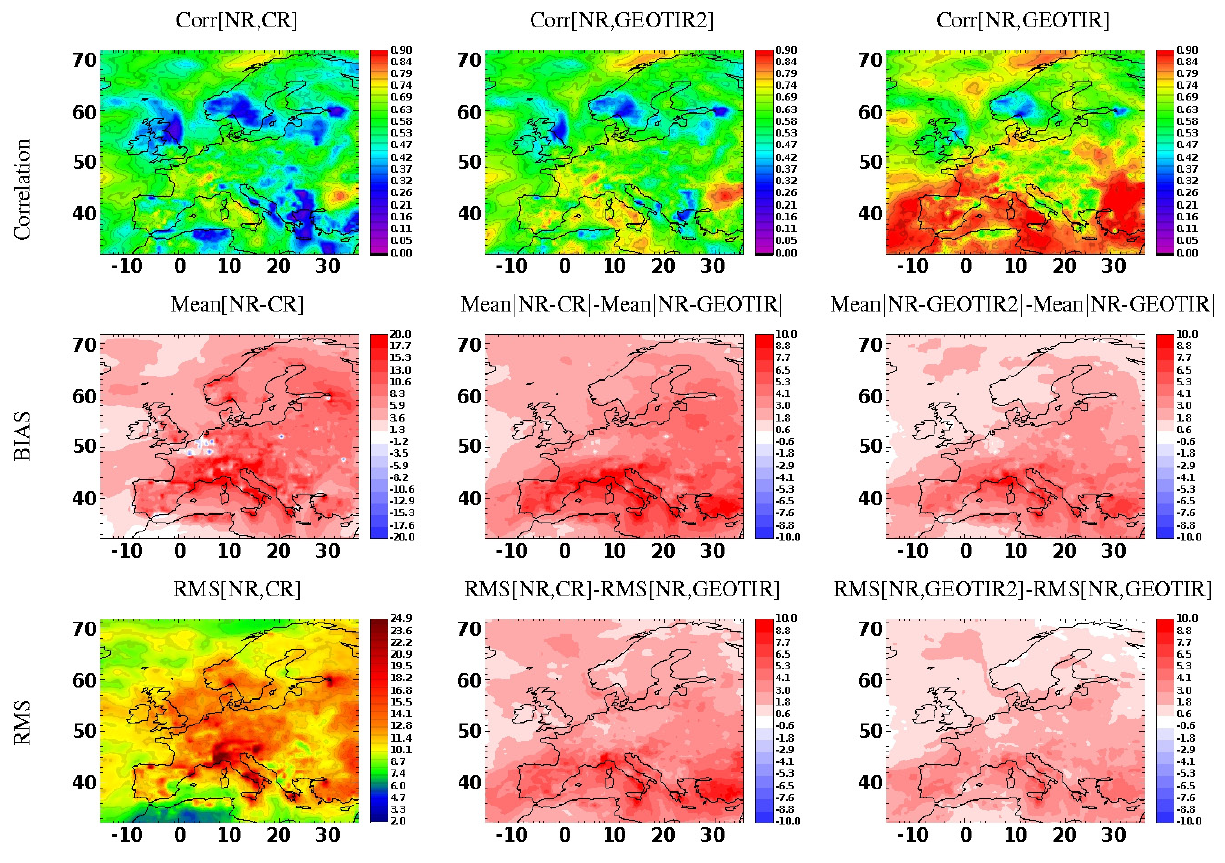
Fig. 12. Same as Fig. 11 (EXP4) but for